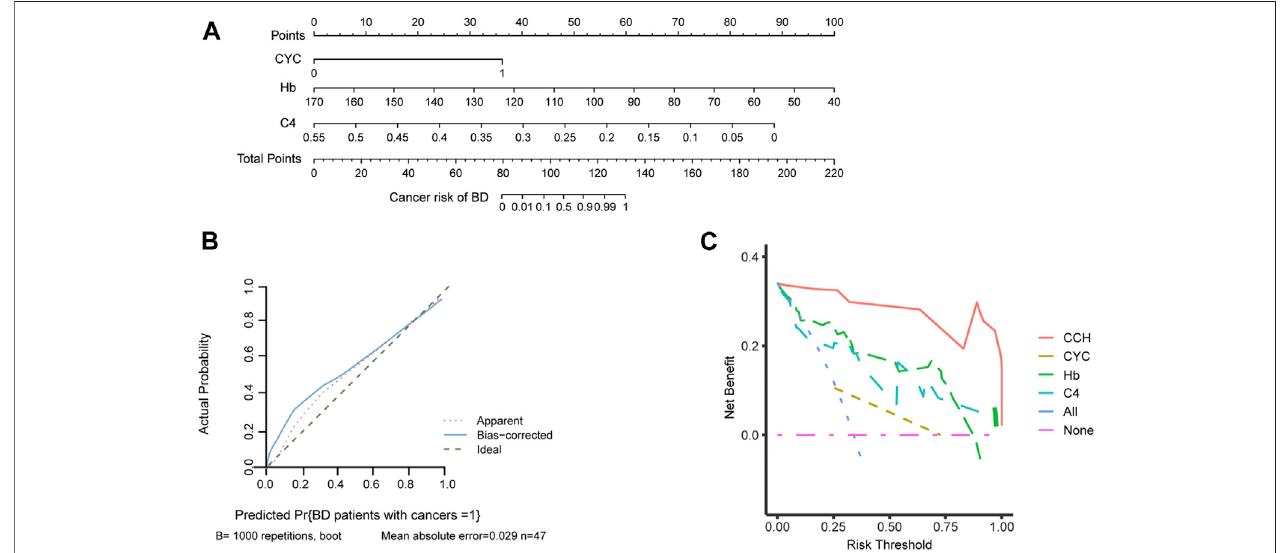
FIGURE4| TheestablishmentofnomogramtopredictthecancerriskofBDpatients. (A) NomogramforpredictingcancerriskofBDpatients.Independentfactors for cancer risk in patients with BD are located on each variable axis, and a line is drawn upward to determine corresponding scores. Three scores were added to obtain the total score, and a line is drawn downward to determine the cancer risk of BD patients. (B) Calibration curve of the nomogram. (C) A decision curve analysis (DCA) of the nomogram. Compared with single factor, our model may potentially yield more clinical net bene fi t in the risk threshold of 0.25 – 0.75. Abbreviations: CCH, cyclophosphamide-complement 4-hemoglobin; CYC, cyclophosphamide; C4, complement 4; Hb,